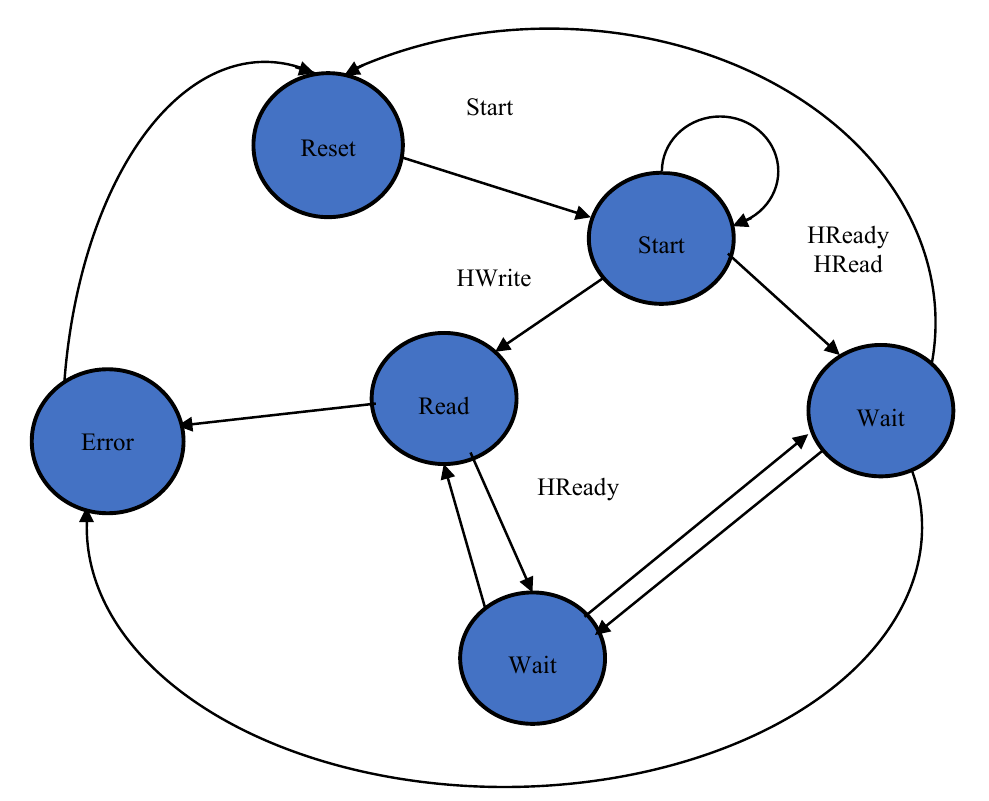
Fig. 6. State diagram for slave